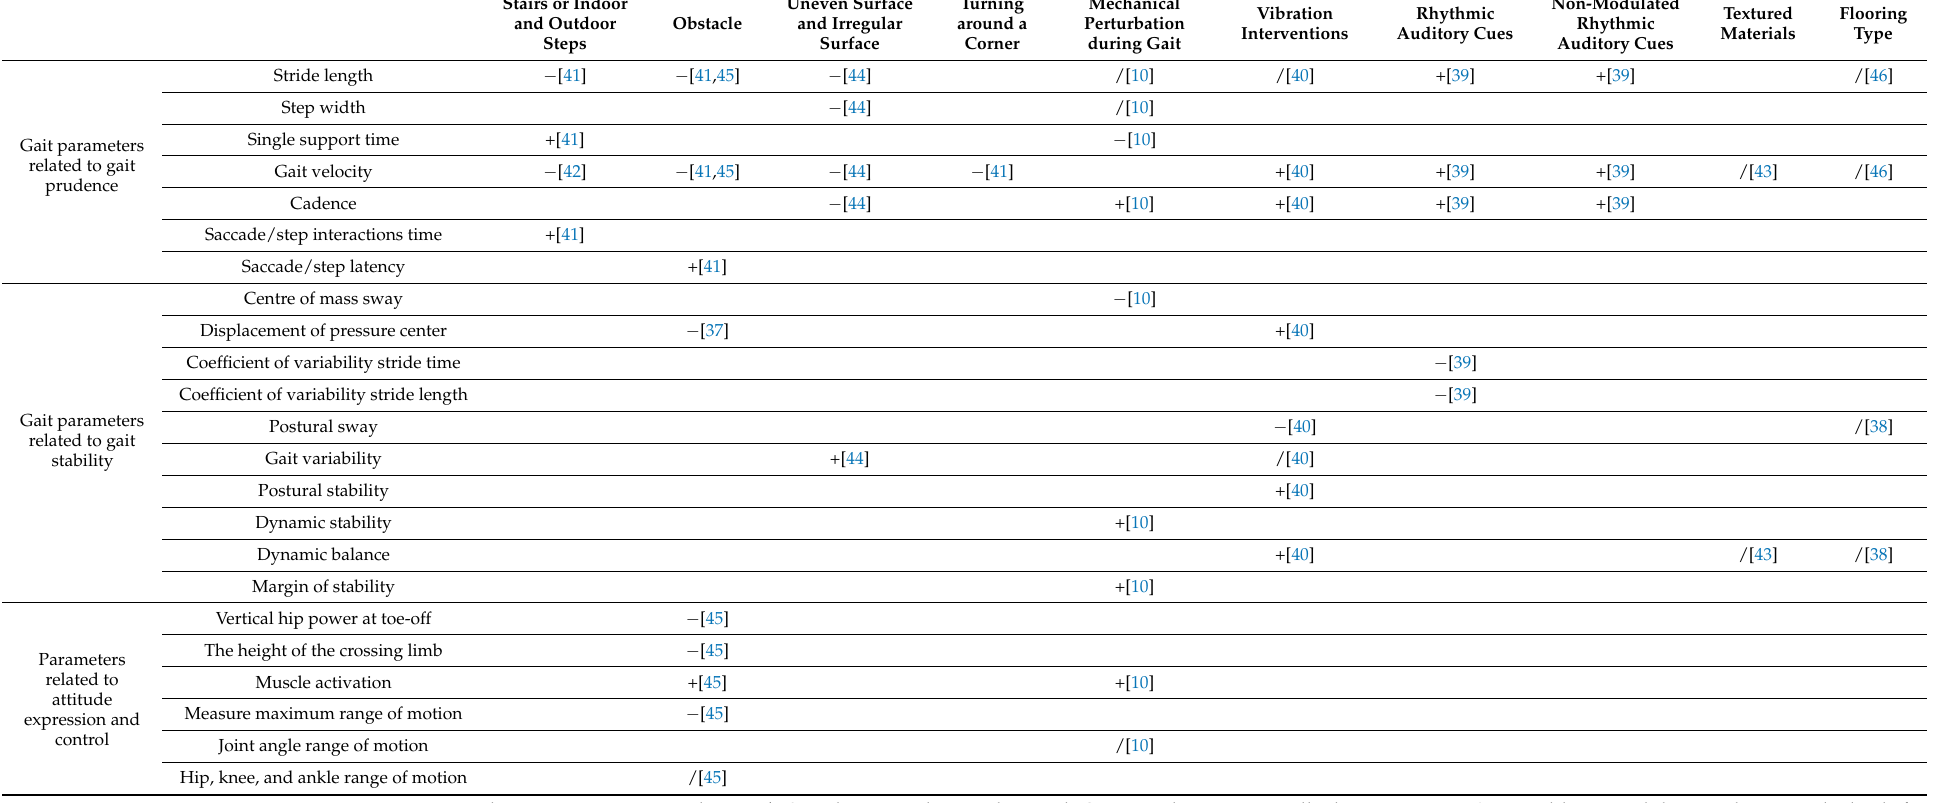
Table 3. Effect of intervention measures on gait